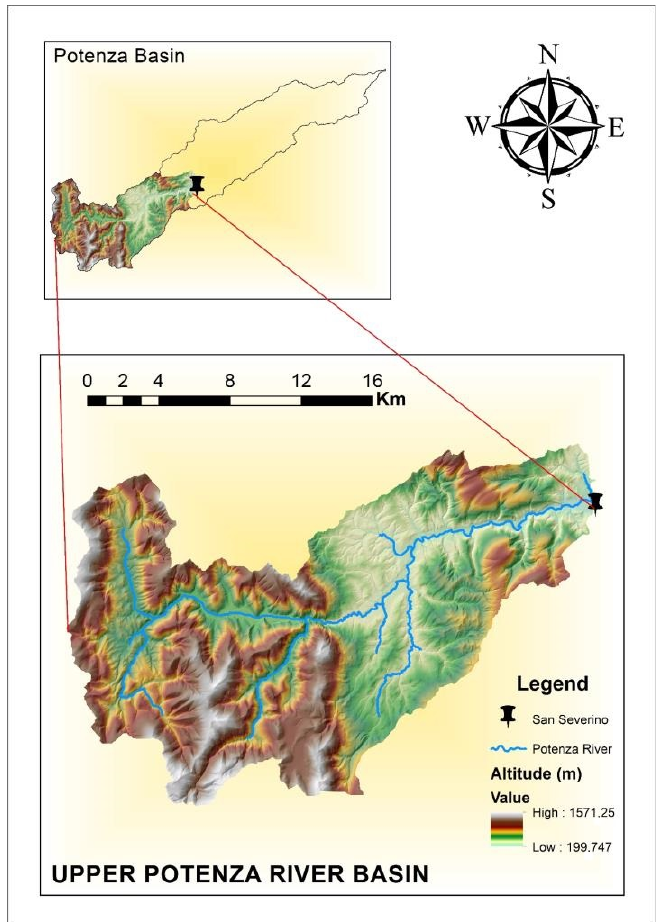
Figure 1. G eography of the study area, upper part of Potenza river basin. Figure 1. Geography of the study area, upper part of Potenza river